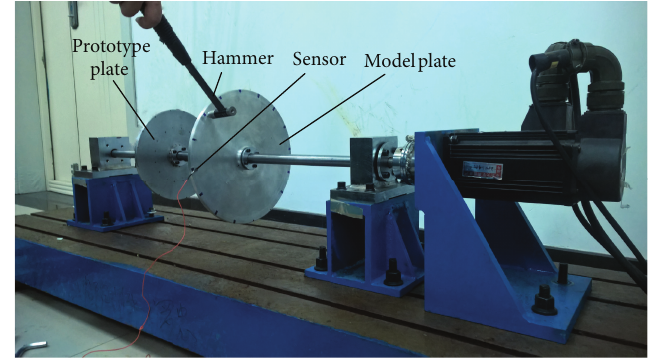
Figure 5: Test setup of the experimental